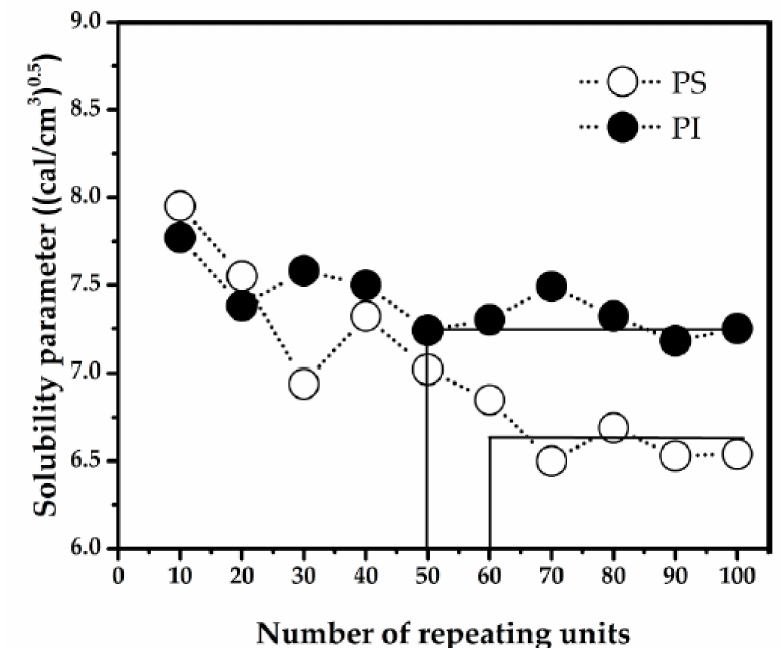
Figure 1. Solubility parameter versus number of repeating units at 393 K for polystyrene (PS) and polyisoprene